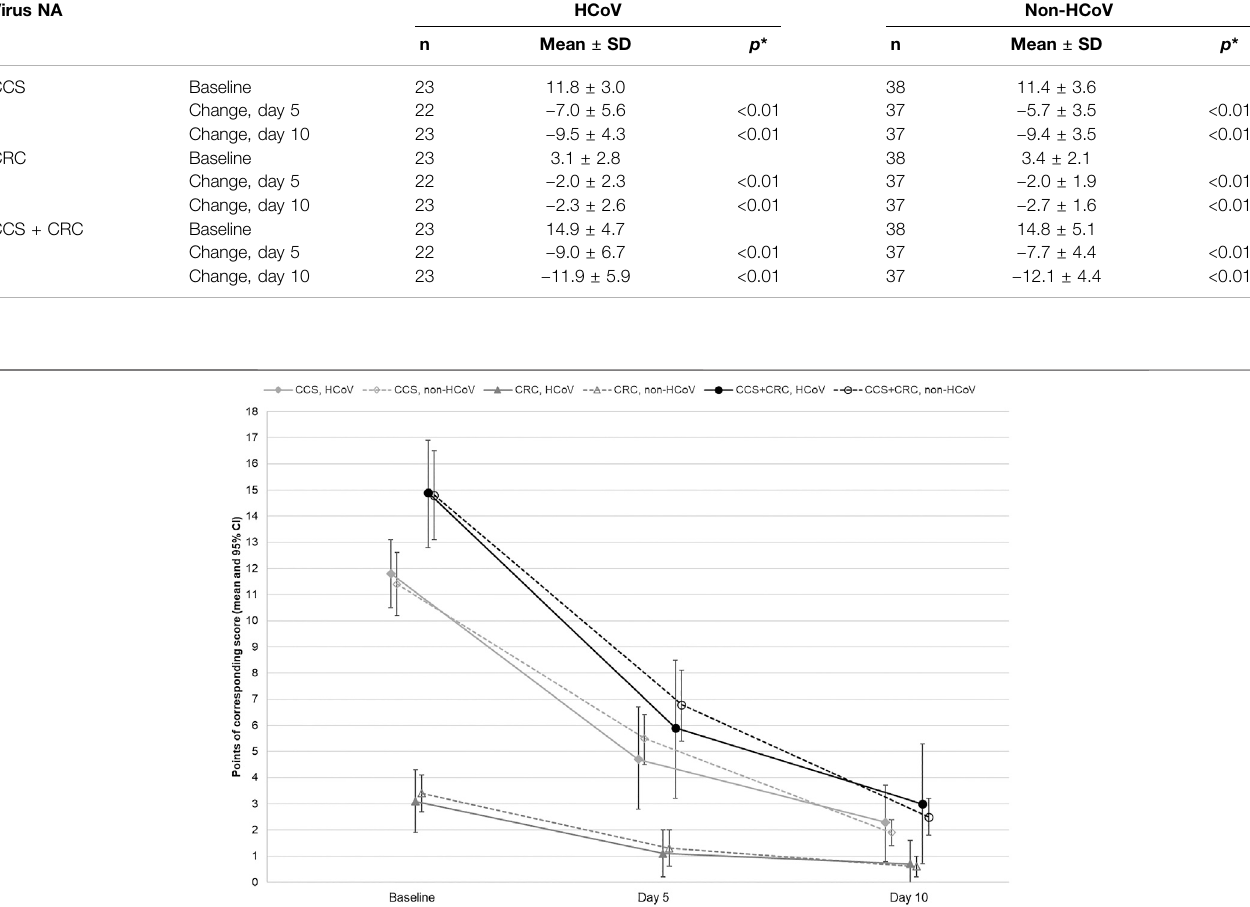
Frontiers in Pharmacology |